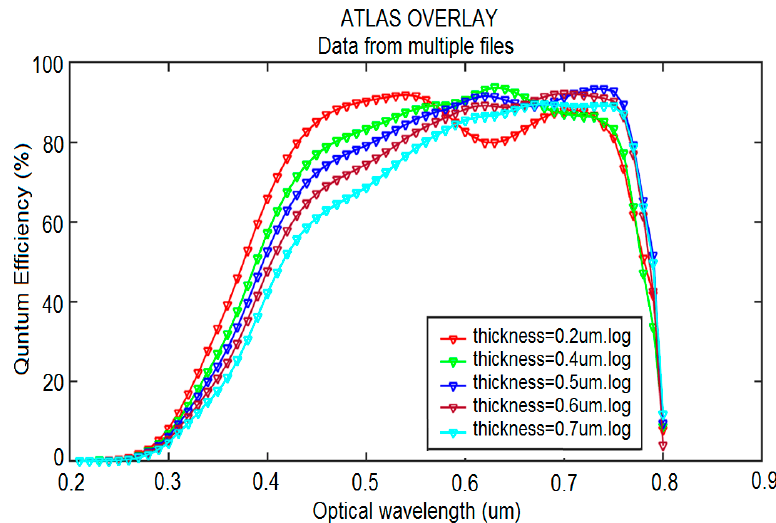
Figure 5. Effect of perovskite layer thickness variation on the quantum efficiency of the inverted planar PSC.